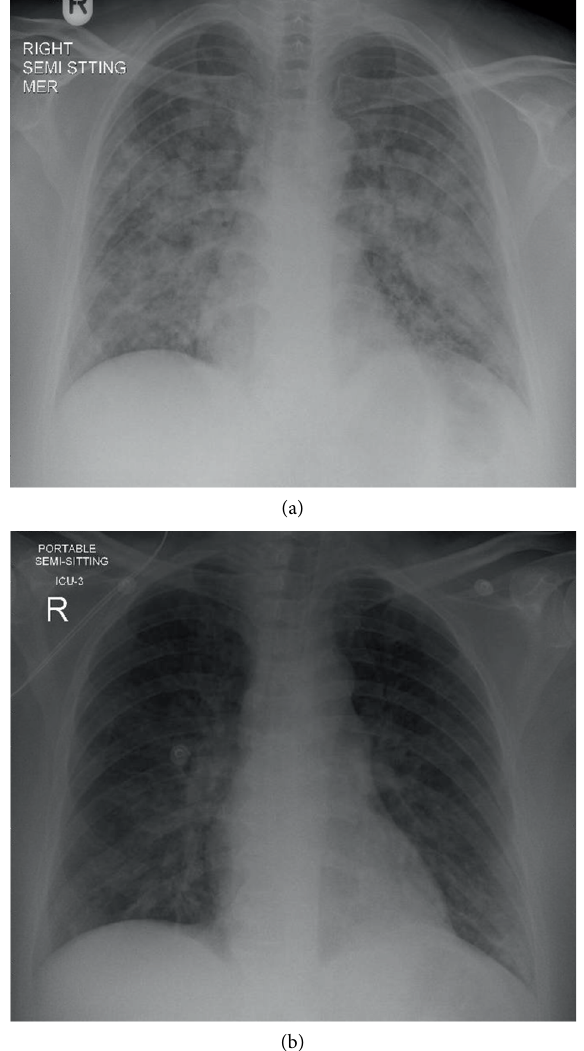
Figure 1: (a) CXR on admission showing multiple confluent and patchy air space opacities noticed diffusely involving both lung fields. (b) CXR after 2 days showing the bilateral lung opacities appear significantly resolved as compared to the previous chest